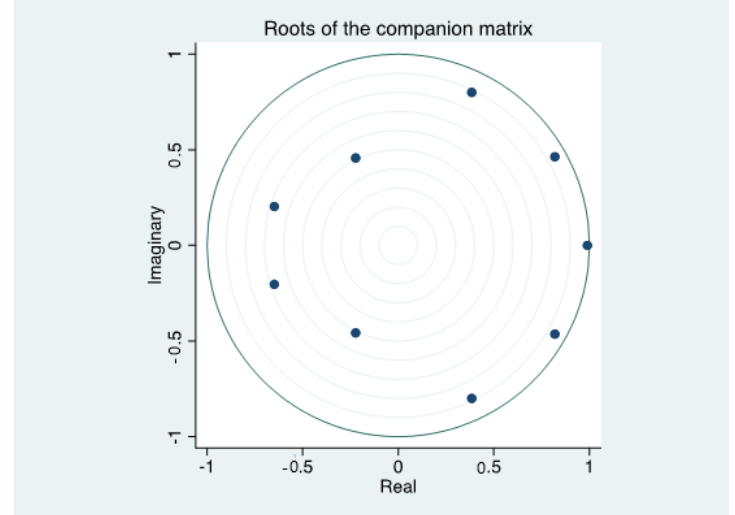
Figure 3. Stability test of VAR(3) system.